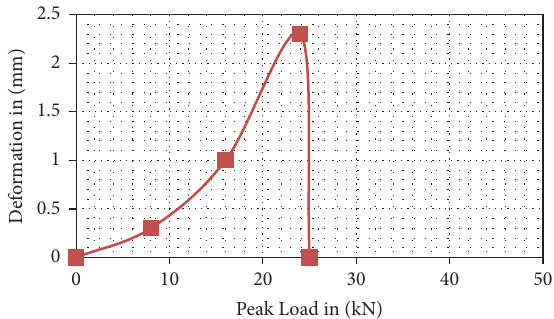
Figure 13: 90 ° fber composite peak load Vs.